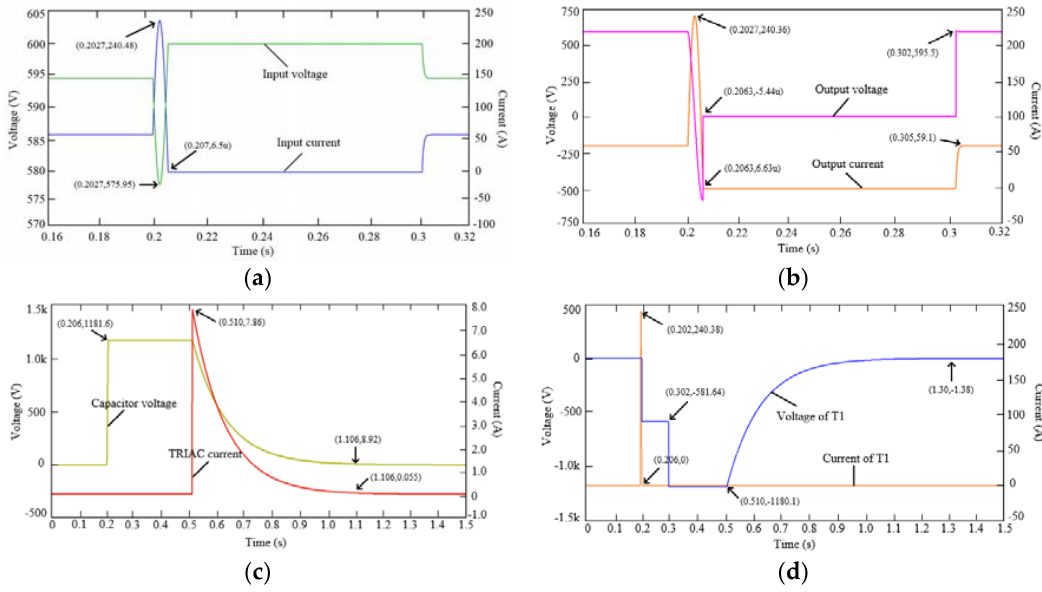
Figure 10. The waveforms of voltage and current at key points: ( a ) waveform of input voltage u in and input current i in ; ( b ) waveform of output voltage u out and output current i out ; ( c ) waveform of Cap voltage u Cr and TRIAC current i TRIAC ; ( d ) waveform of voltage u T1 and current i T1 on T 1